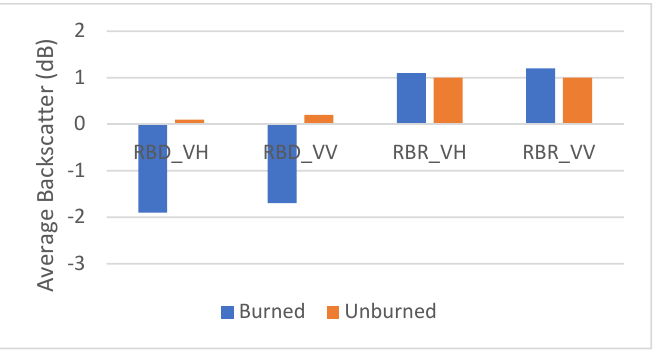
Figure 6. The average backscatter of the burnt and unburnt areas in each variable (RBD_VH, RBD_VV, RBR_VH, and RBR_VV).